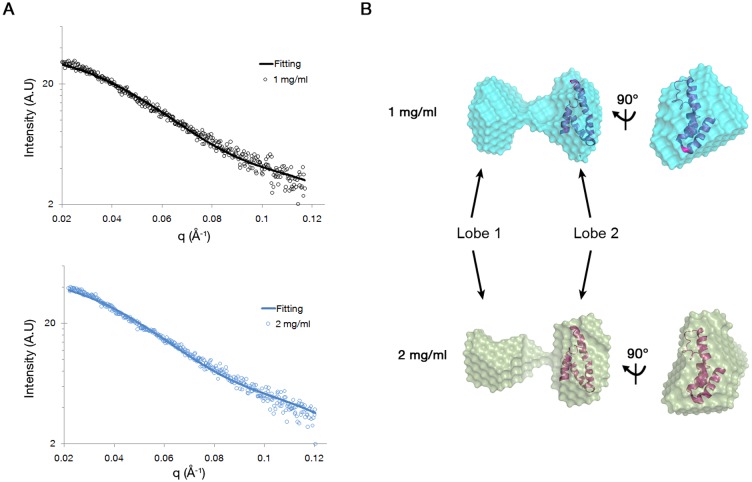
SAXS analysis of the BteA287.(A) Experimental data of the BteA287 (dots represent experimental data, and lines show fit) (B) Dummy-ball models (DBMs) of mg/ml (30 µM, upper panel) and 2 mg/ml (60 µM, lower panel) fitted onto the core deposited structure of BteA115–220 (PDB code 2JPF).